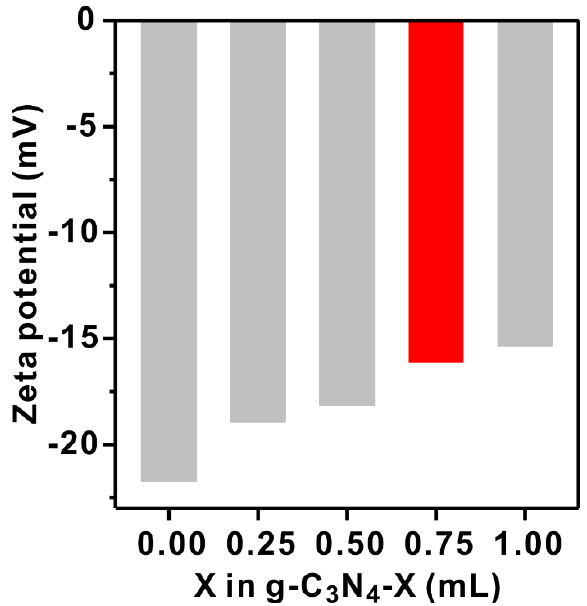
Figure 4. Zeta potential of g-C 3 N 4 -X samples.